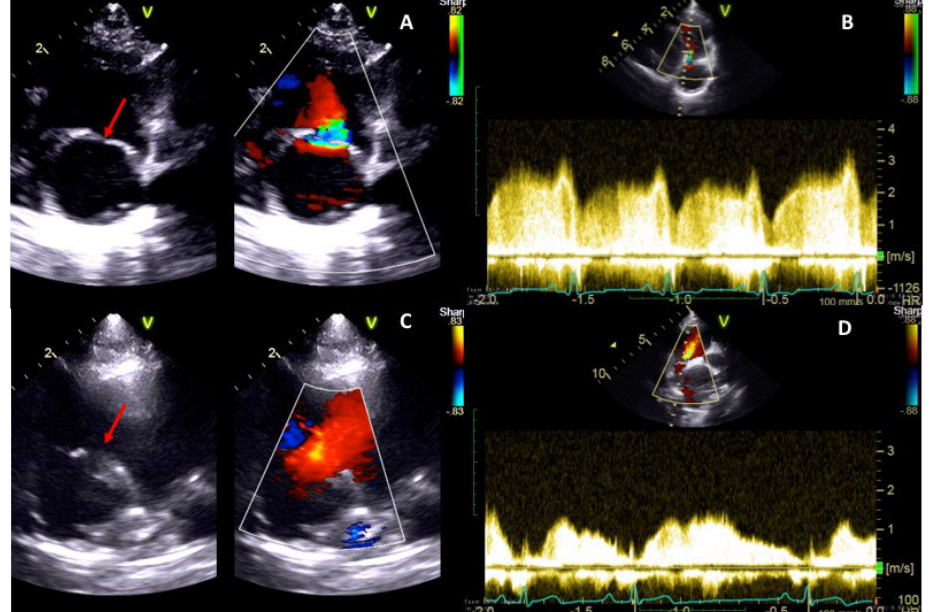
Figure 2. Two-dimensional, color, and spectral Doppler echocardiographic images of case 1. Right parasternal oblique view focused on the right atrium and caudal vena cava before ( A ) and after ( C ) the percutaneous balloon dilation of cor triatriatum dexter. After the procedure, the diameter of the perforation (red arrows) of the membrane increased markedly and a laminar flow could be seen through the membrane with color Doppler ( C ). Spectral Doppler images demonstrated a large reduction in the trans-membrane peak flow velocity (from 3.0 m/s to 1.2 m/s) ( B , D ). CaRA: caudal right atrium chamber; CrRA: cranial right atrium chamber.